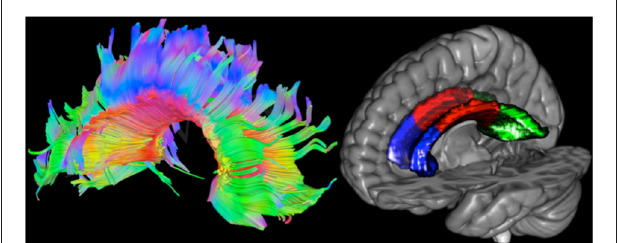
FIGURE 2 | Left: tracts of the corpus callosum (CC) projected on the diffusion weighted image of one healthy control (HC) participant. Red, green and blue represent left to right, anterior to posterior and superior to inferior directions, respectively. Right : masks of the CC projected on the Collins MNI-reference brain. The genu is colored in blue, the body in red and the splenius in